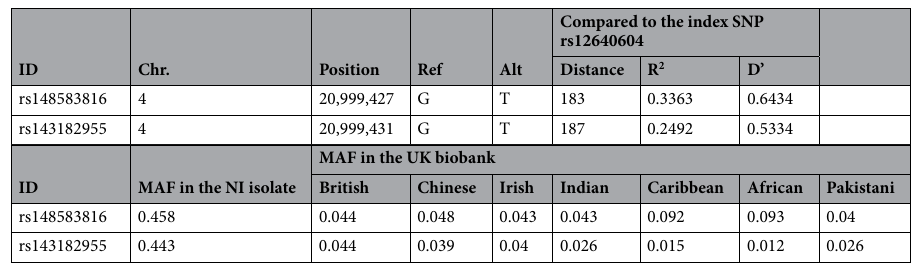
Table 4. Statistics of the two potential functional